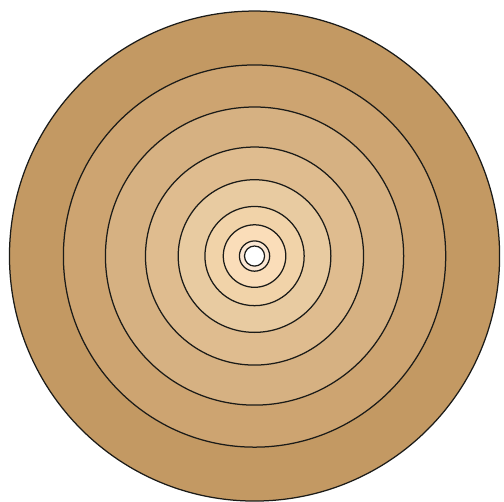
Figure 2: Soil stratification in plastic zone.